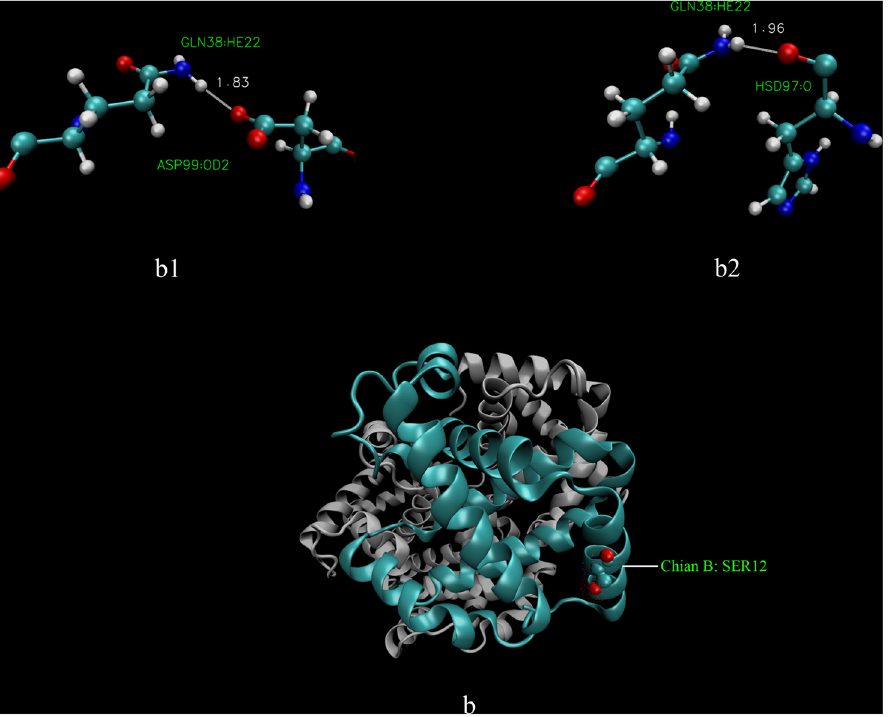
Fig 6. The reformed of 2 hydrogen bonds at α 2 β 1 interface in hwHb1. (b1 – b2) Hydrogen bonds at α 2 β 1 interface present in hwHb1 and lost in hsHb1, (b) Three-dimensional structure of hwHb1 with β